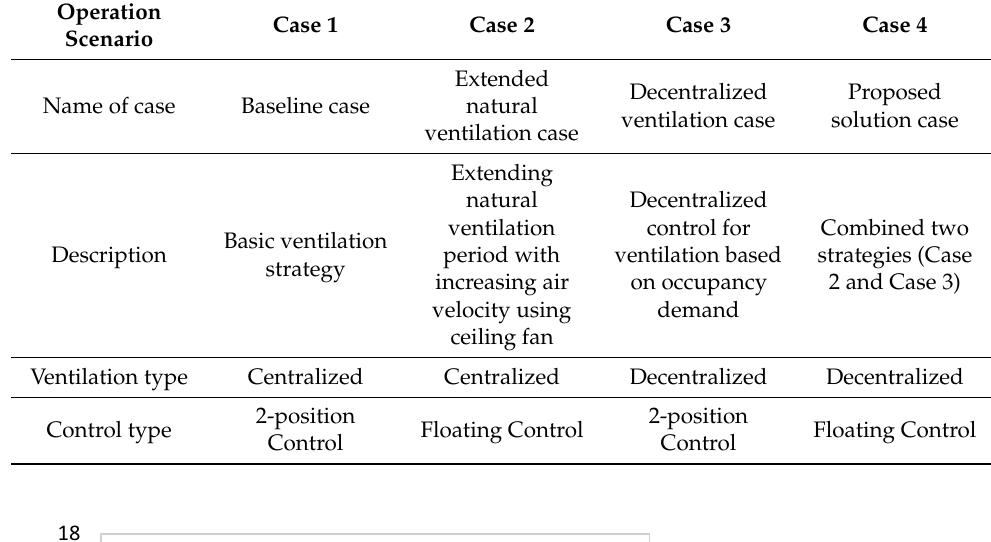
Table 5. Simulation cases description.